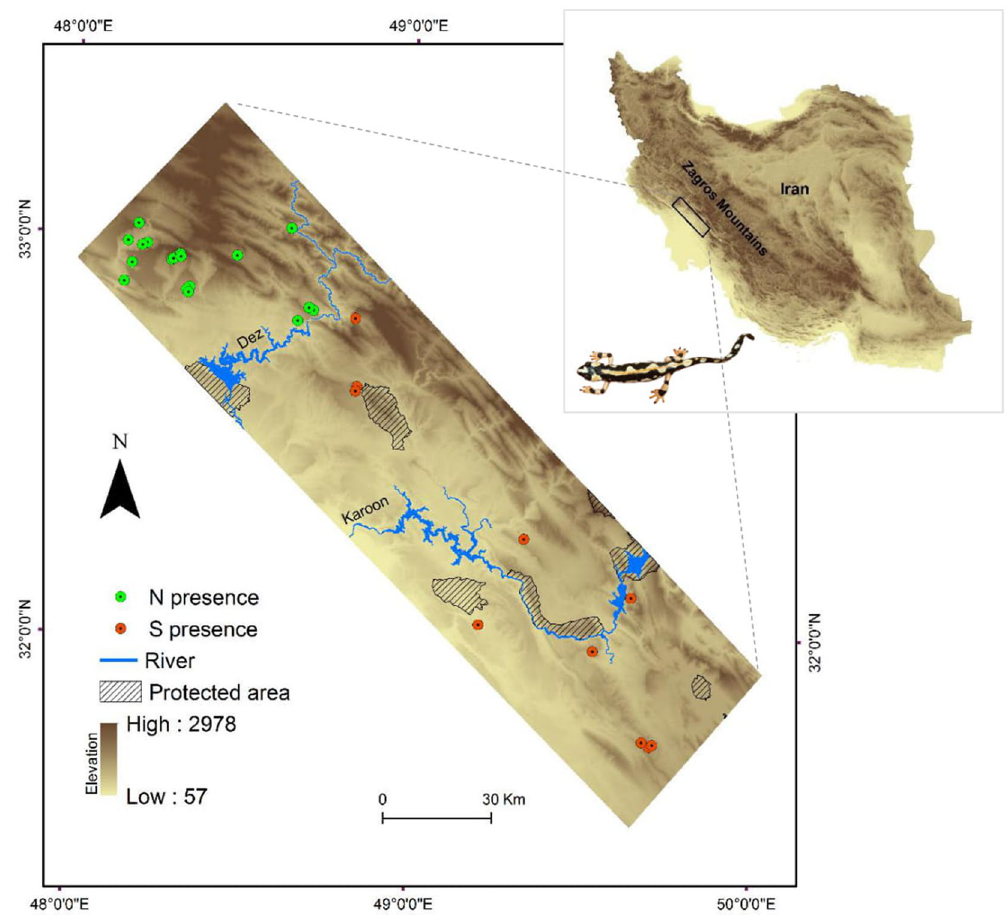
Figure 1. Geographic distribution of springs and ponds inhabited by the northern (N) and the southern (S) lineages of Neurergus kaiseri in southwestern Zagros Mountains, Iran. The maps were generated in ArcGIS